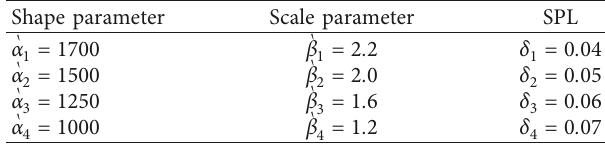
Table 3: Values of location and scale parameter with SPL of b i .